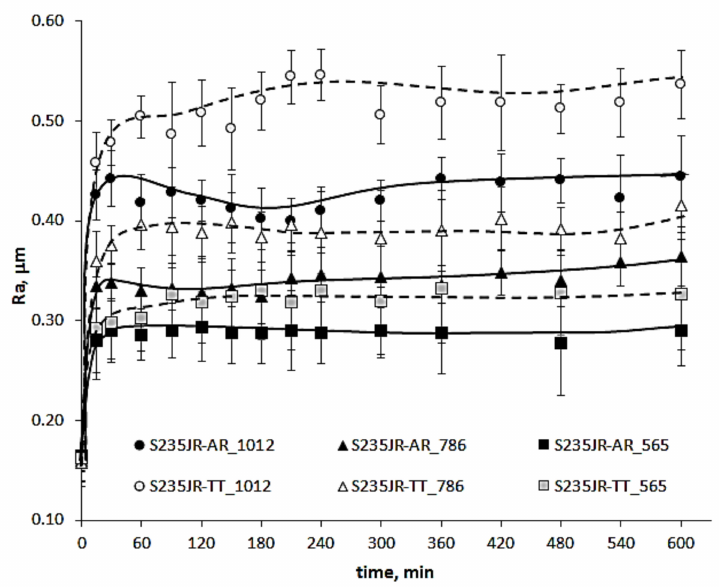
Figure 14. Development of surface roughness (Ra parameter) during slurry